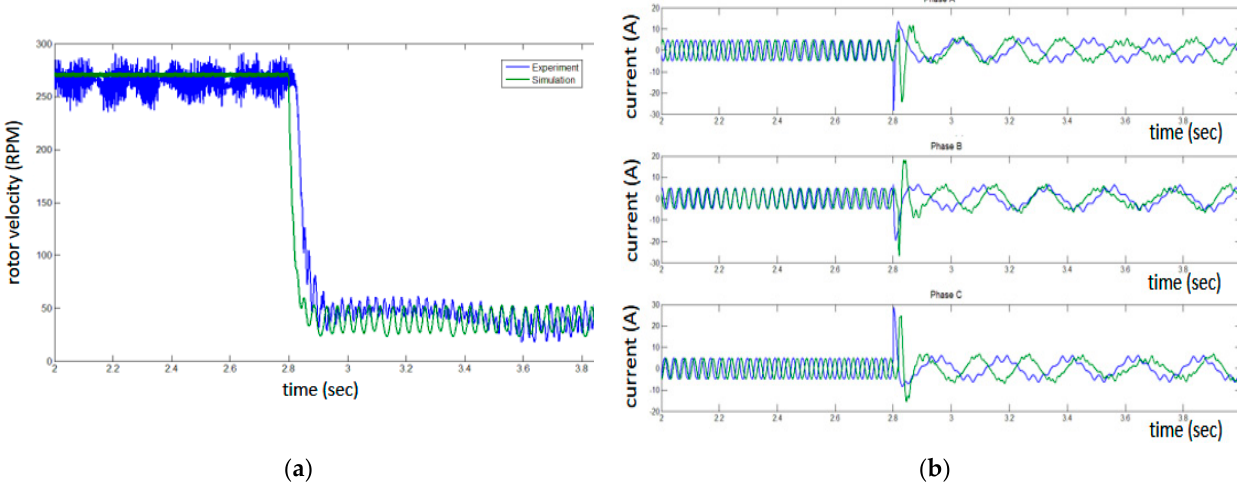
Figure 12. Short circuit test response. ( a ) Comparison of the rotor velocities. ( b ) Comparison of the stator currents. The plots show a comparison of the hybrid model (green trace) and the experimental measurements (blue).